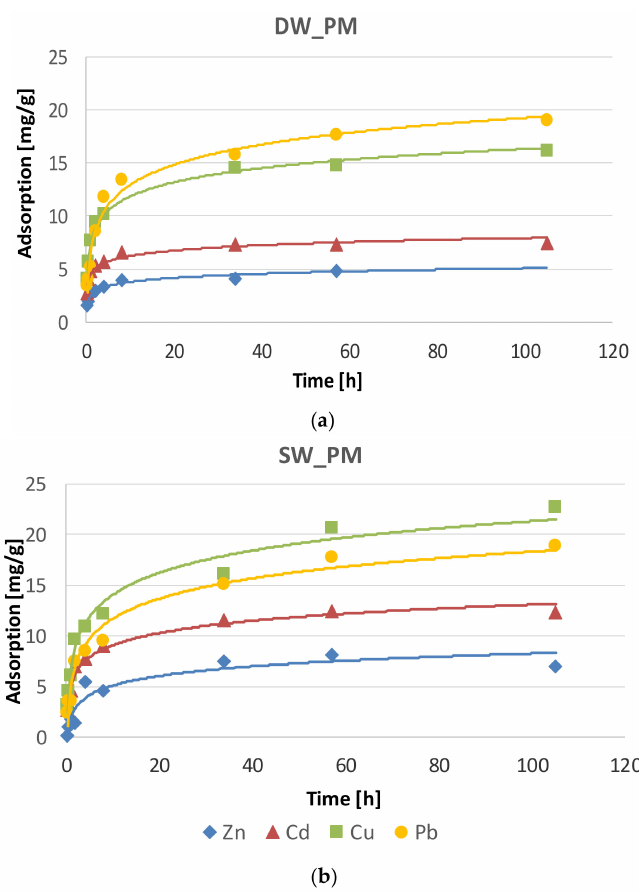
Figure 3. The kinetics of metal ion binding in the presence of phosphate by alginate matrices cross-linked with Fe 3 + ions in: ( a ) deionized water enriched with phosphate and metal ions (DW_PM) and ( b ) e ffl uent from a sludge enriched with phosphate and metal ions